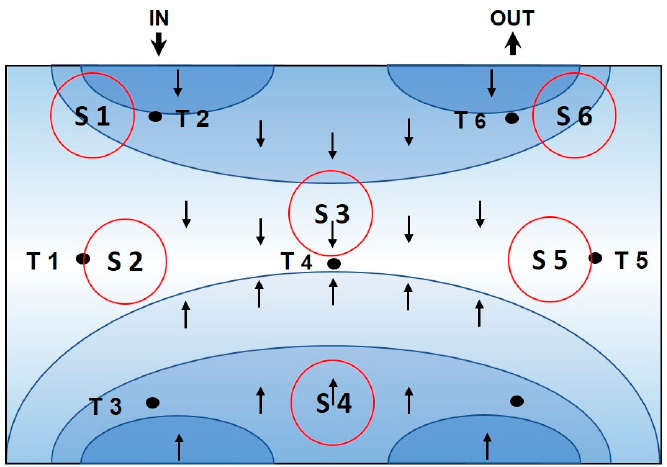
Figure 4. Sketch of the freezing characteristics inside the small-scale device based on the temperature data. Red circles indicate the points of sampling, T the temperature probes. Blue ellipsoids and arrows indicate the direction of the freezing front.